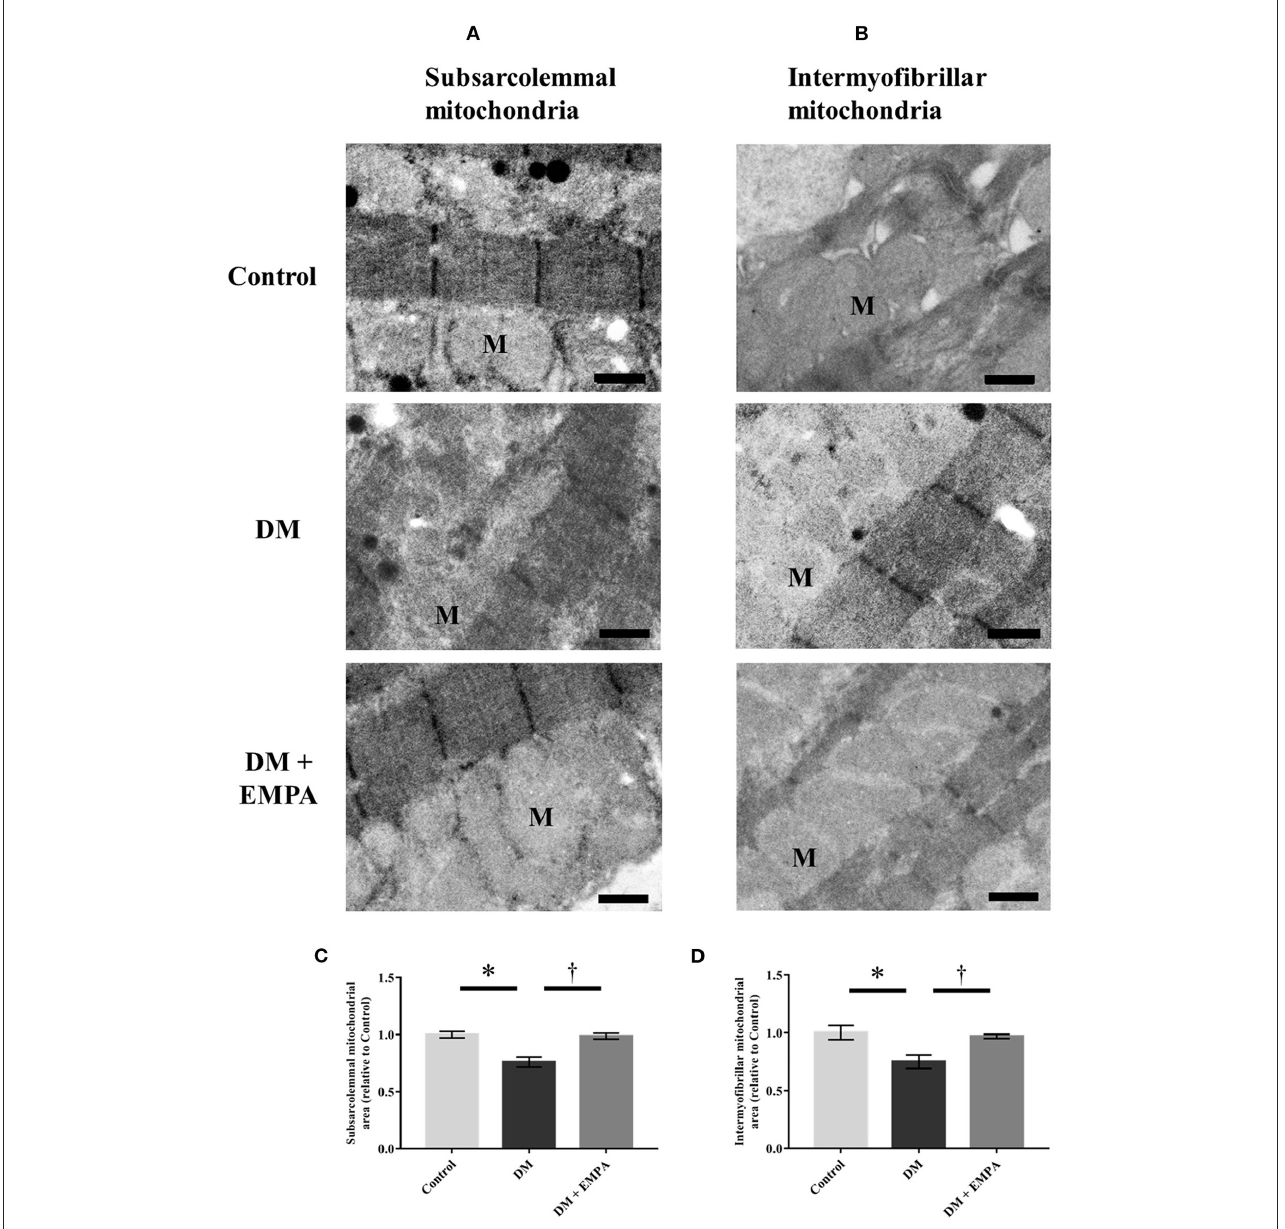
FIGURE5 Morphological assessment of mitochondria in the atrial tissue. Representative electron microscopic images of subsarcolemmal [ (A) ; scale bar = 6 µ m] and intermyofibrillar [ (B) ; scale bar = 6 µ m] mitochondria. Summarized data of area of subsarcolemmal (C) and intermyofibrillar (D) mitochondria ( n = 3 per group). Data are expressed as mean ± SE. * p < 0.05: vs. Control, † p < 0.05: vs. DM (One-way repeated ANOVA post hoc Tukey’s multiple-comparison test). M, mitochondria; DM, diabetes; EMPA,